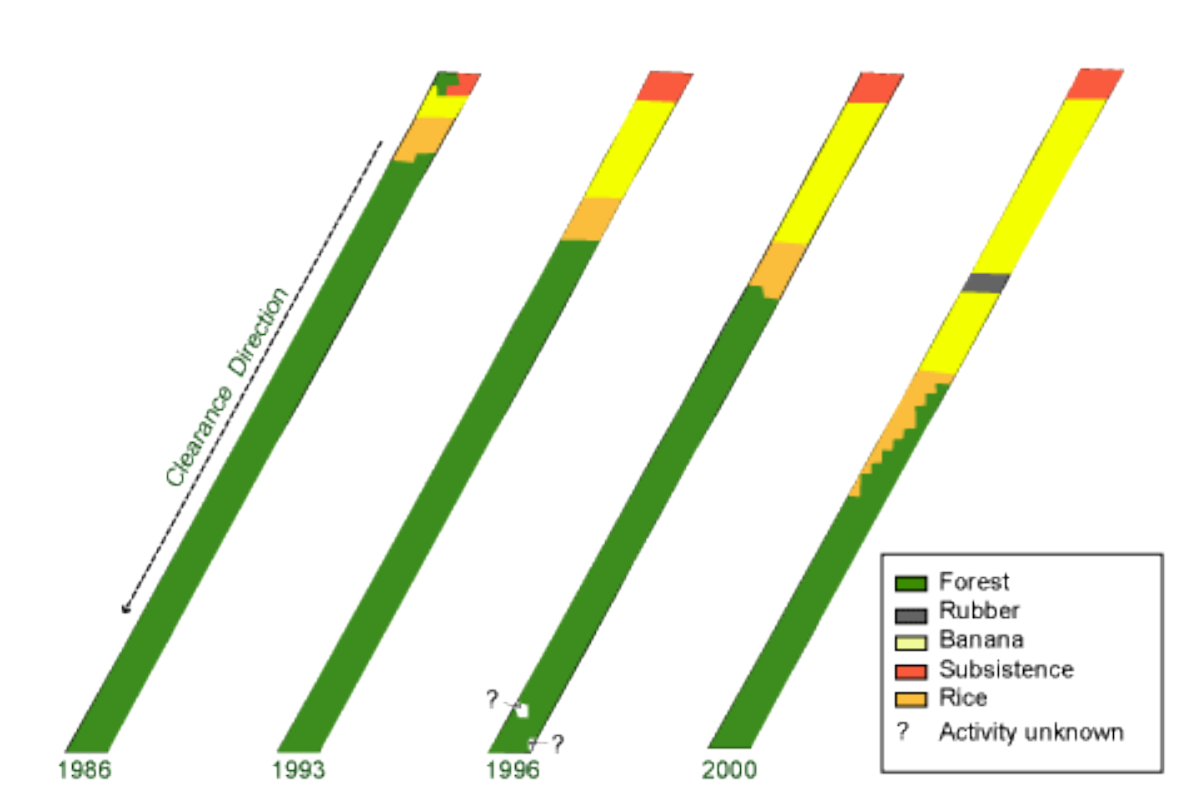
Fig. 3. A sequence of land-use maps illustrating a farm from Community III where conventional crops were grown throughout the period